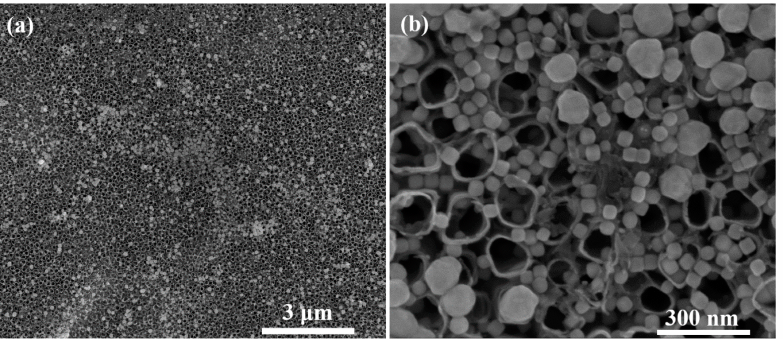
Figure 7. ( a ) SEM at low ( b ) and high magnification: images of cubic Ag nanoparticles/nanocubes with an edge length of around 45 nm deposited by the droplet method on TiO 2 NT in anatase form with an inner diameter of around 110 nm and a wall thickness of around 20 nm are shown. SERS spectroscopy is one of the most sensitive analytical tools available and is widely used in medicine. Ref. [63] is reprinted with permission. Copyright © 2019, MDPI